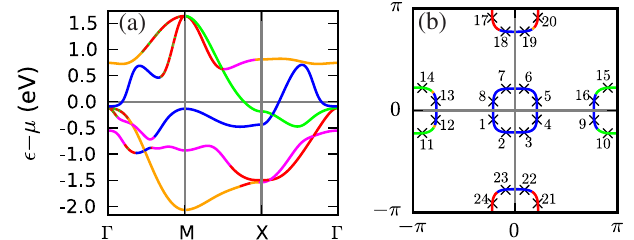
FIG. 13. (a) The band structure and (b) the Fermi surfaces of the modified band structure with an electron pocket added at (cid:1) , colored according to the dominant orbital content. The color ; green, d ; blue, d ; orange, d ; and code is red, d xz yz xy x 2 (cid:1) y 2 . The numbered crosses show the center of magenta, d 3 z 2 (cid:1) r 2 FIG. 15. Typical RG flows and the superconducting gaps as- Fermi-surface patches used in the FRG calculations. sociated with FS setup for the three-pocket scenario with Þ ¼ ð 0 : 2 ; 0 : 8 Þ eV . Leading form factor is denoted in blue, ð J ;J 1 2 subleading form factor in green.